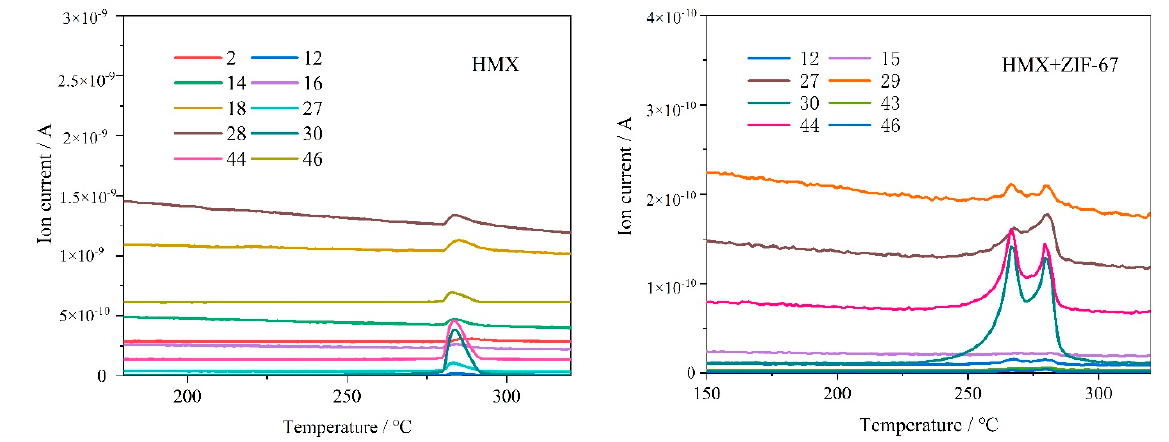
Figure 8. MS spectrogram for the products of HMX and HMX+ZIF-67.